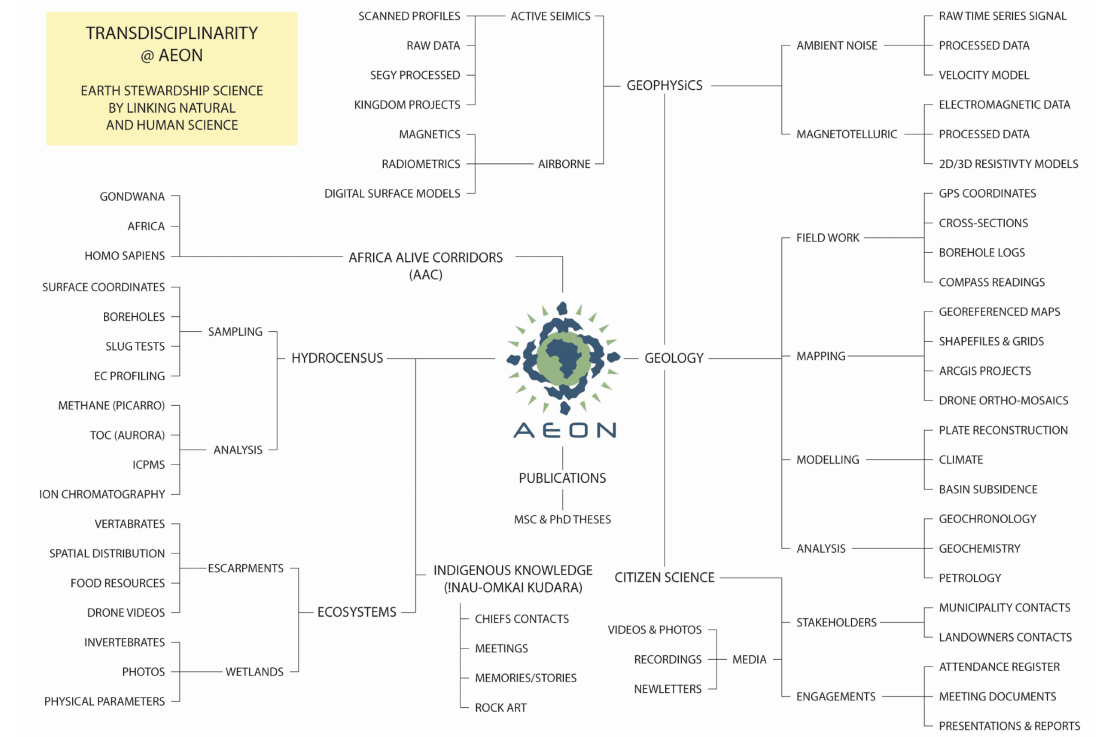
Figure 14. Database architecture used to manage AEON’s earth stewardship science projects, publications and theses.